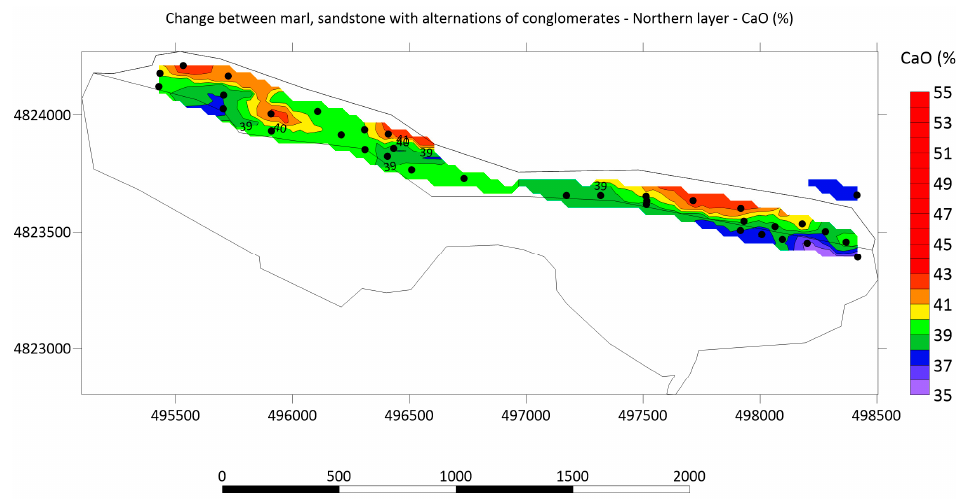
Figure 7. Variograms for the unit (1), northern layer.